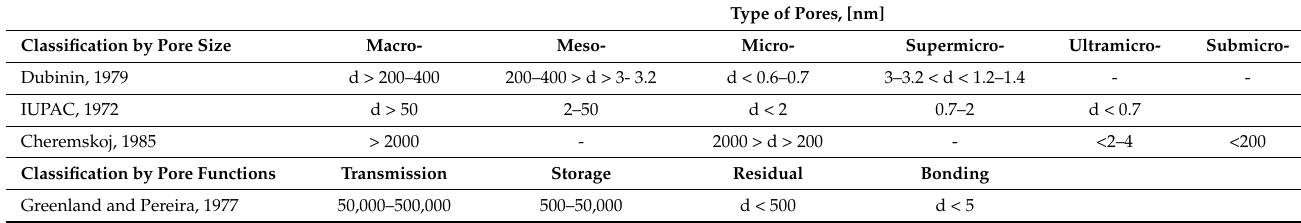
Bold headings indicate different pore